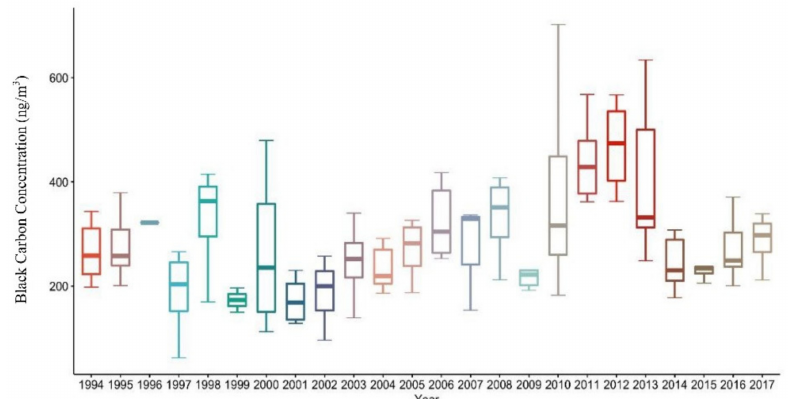
Figure 2. The annual concentration of black carbon aerosol in Mt. Waliguan from 1994 to